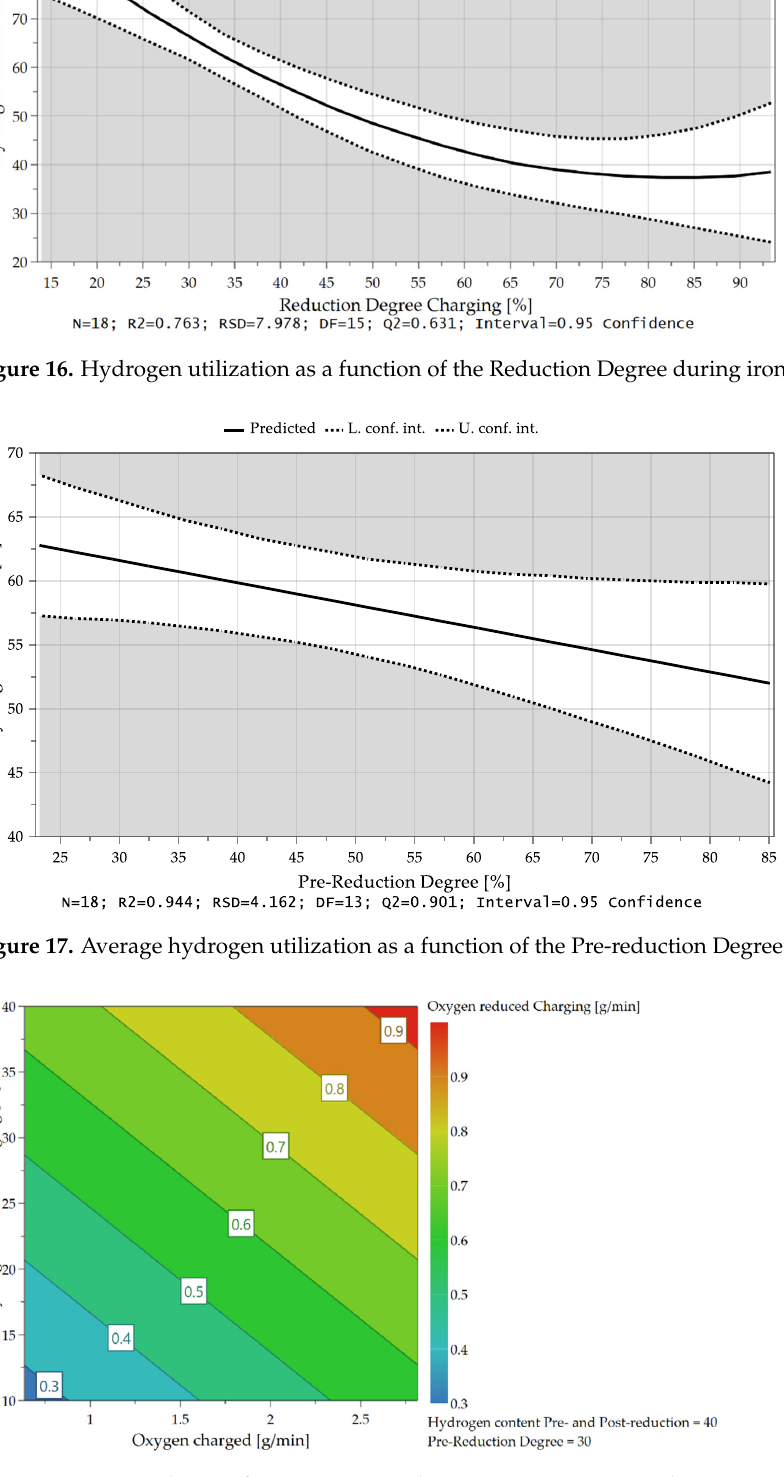
Figure 18. Dependence of oxygen removal rate on H 2 content and oxygen supply during the charg ‐ ing phase.